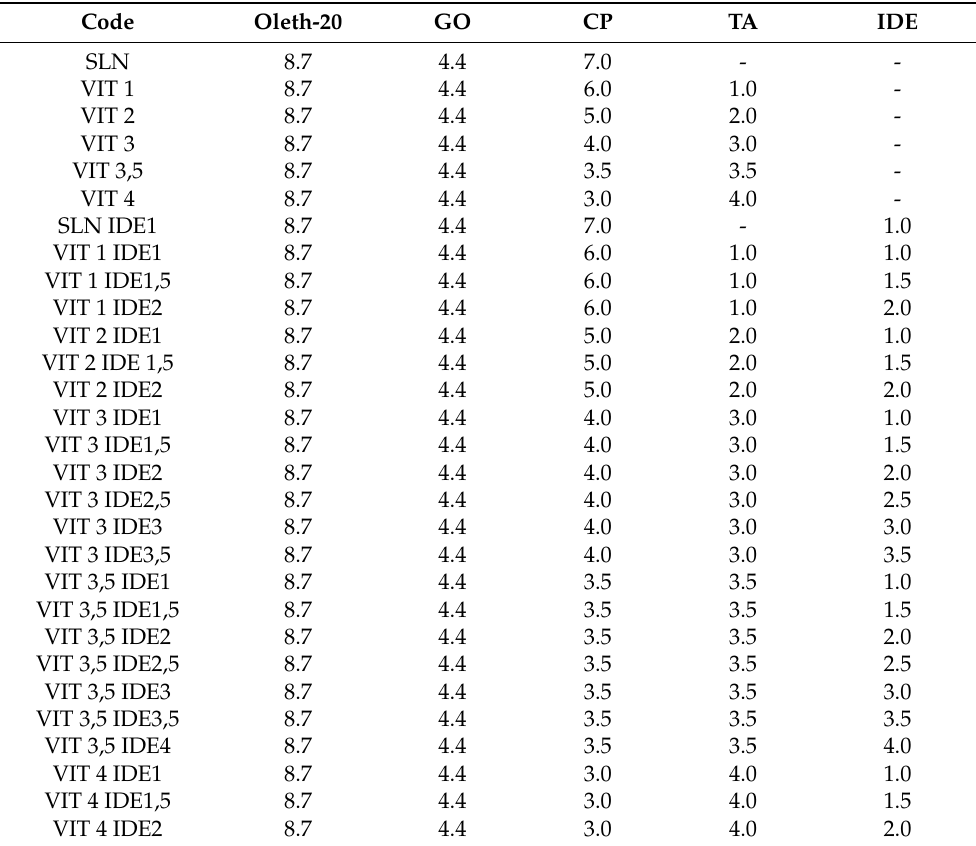
Table 1. Composition (% w / w ) of lipid nanoparticles containing different percentages of toco- pheryl acetate and idebenone. GO = glyceryl oleate; CP = cetyl palmitate; TA = tocopheryl acetate, IDE =